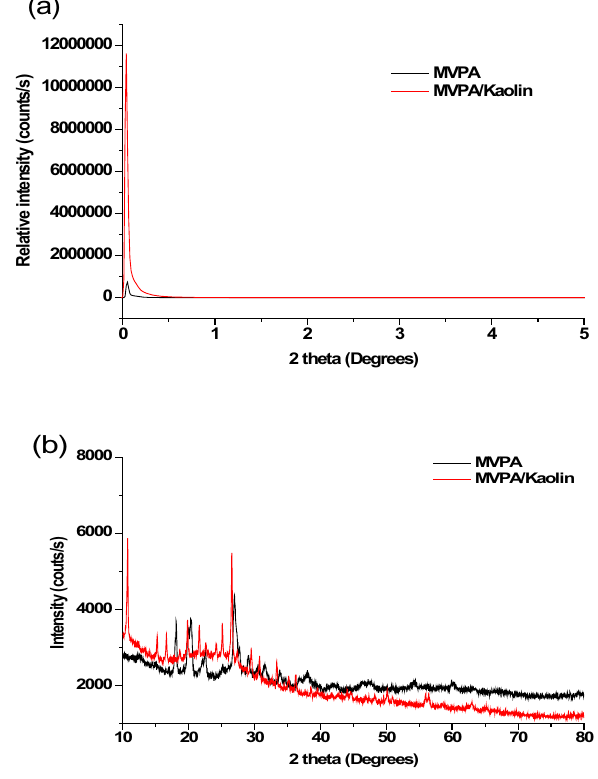
Fig. 2 X-ray diffraction pattern of MVPA and MVPA/Kaolin [ a low- angle and b wide-angle